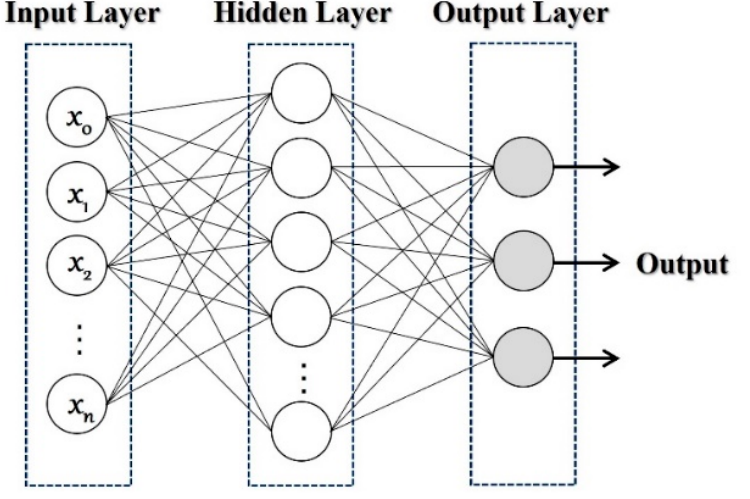
Figure 3. Conceptual diagram of the MLP.